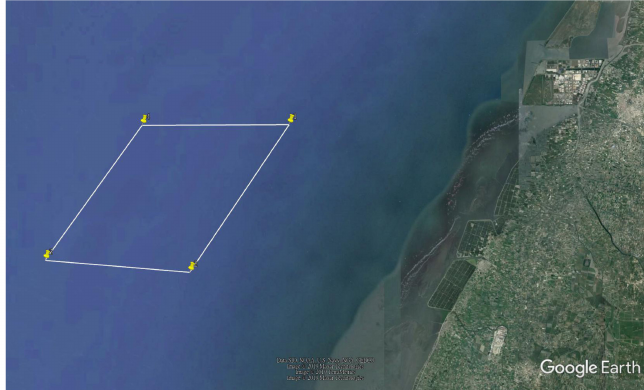
Figure 2. Satellite image showing the studied sea area.